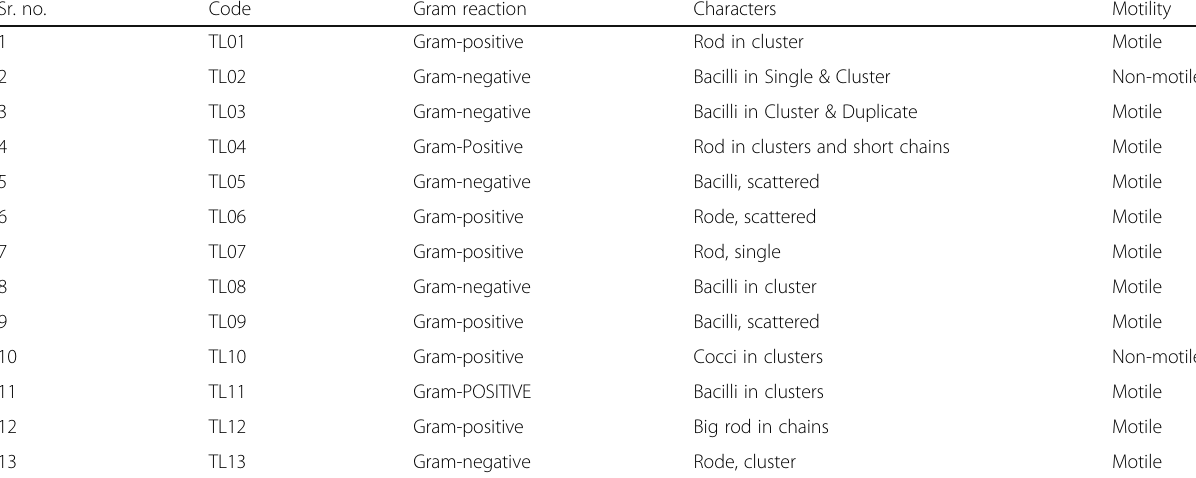
Table 4 Morphological characterization of isolates form used leech under 100× magnification Sr.